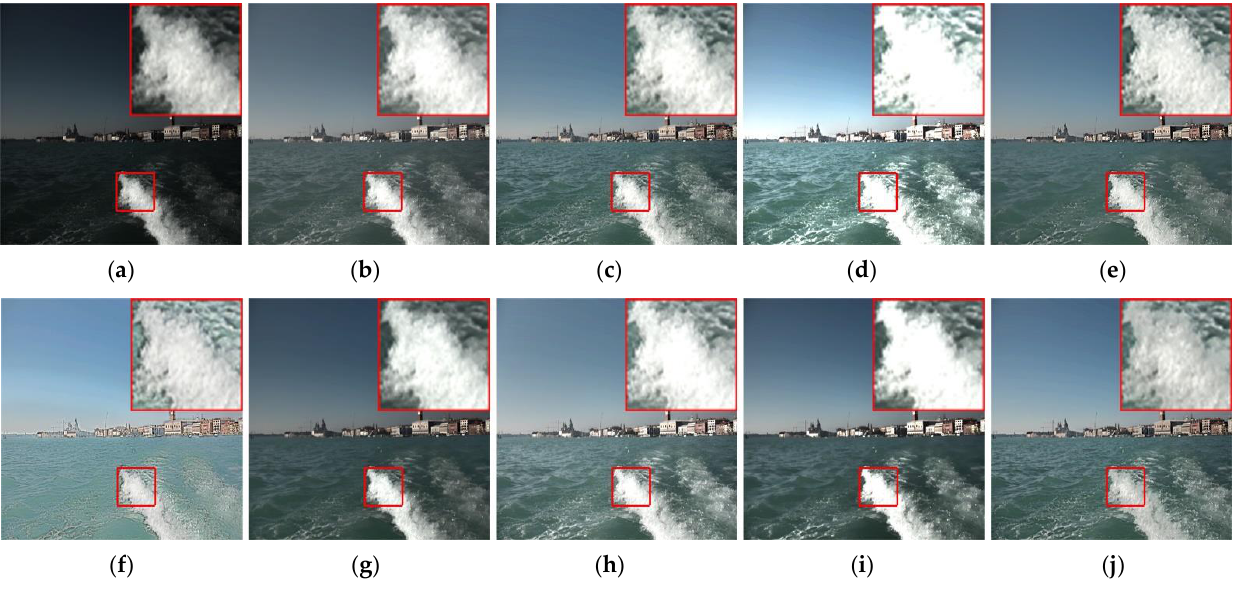
Figure 17. Enhanced results of “River” image. ( a ) Original image; ( b ) BIMEF; ( c ) MF; ( d ) LIME; ( e )